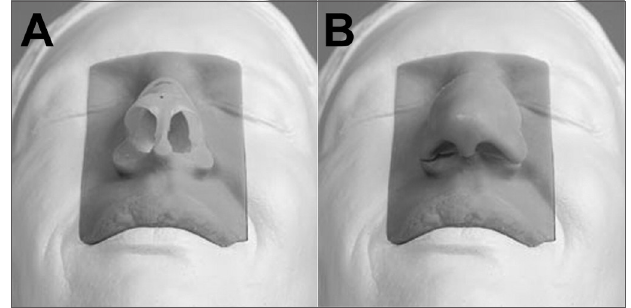
Figura 5. Imagens do modelo S.I.M.O.N.T. A: imagem endoscópica (0-graus, 4mm) de dissecação anatômica em cadáver fresco. B: imagem endoscópica (0-graus, 4mm) de dissecação anatômica em modelo S.I.M.O.N.T. Note semelhança entre as estruturas e a utiliza- ção de instrumentos cirúrgicos reais, também utilizados em cirurgias tradicionais. (CM) corneto médio; (BE) bolha etmoidal; (PU) processo uncinado; (CI) corneto inferior; (S) septo nasal. C: Médico realizando dissecação das tarefas solicitadas em modelo S.I.M.O.N.T. Note que são utilizados os mesmos instrumentos de cirurgias nasossinusais.